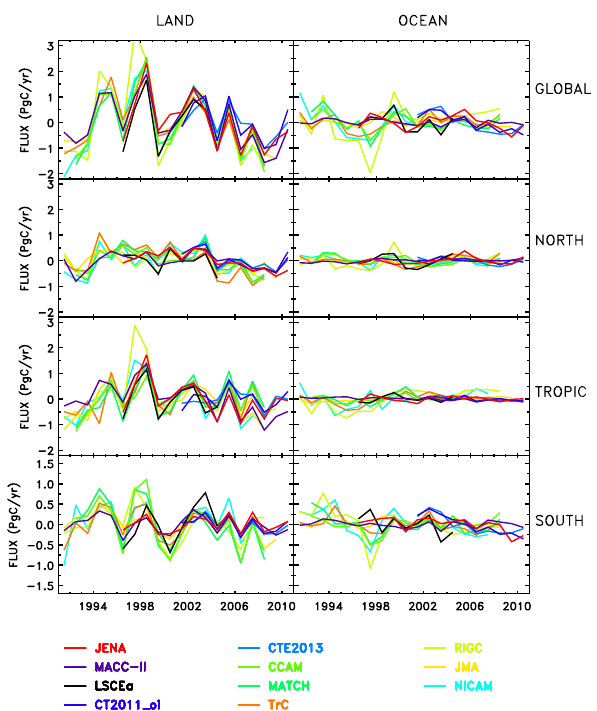
Fig. 6. Annual mean anomalies of the individual participating in- version posterior flux estimates. Shown here are the fossil-fuel- corrected natural land (first column) and natural ocean (second col- umn) carbon exchange for the same regions as Fig. 4: global, north ( > 25 ◦ N), tropics (25 ◦ S–25 ◦ N) and south ( < 25 ◦